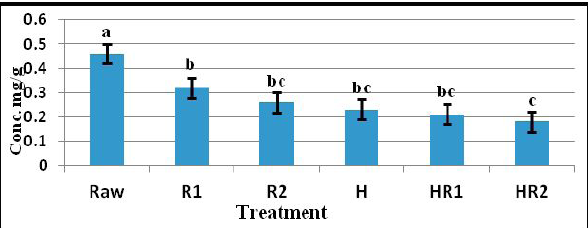
Fig. 1(a). Effects of γ-irradiation and/or extrusion on tannic acid of soy flour. a,b,c, Means within same column followed by different letters are significantly different at (P<0.05), Val- ues are means of three replicates (± SE). Raw→ raw soy flour,